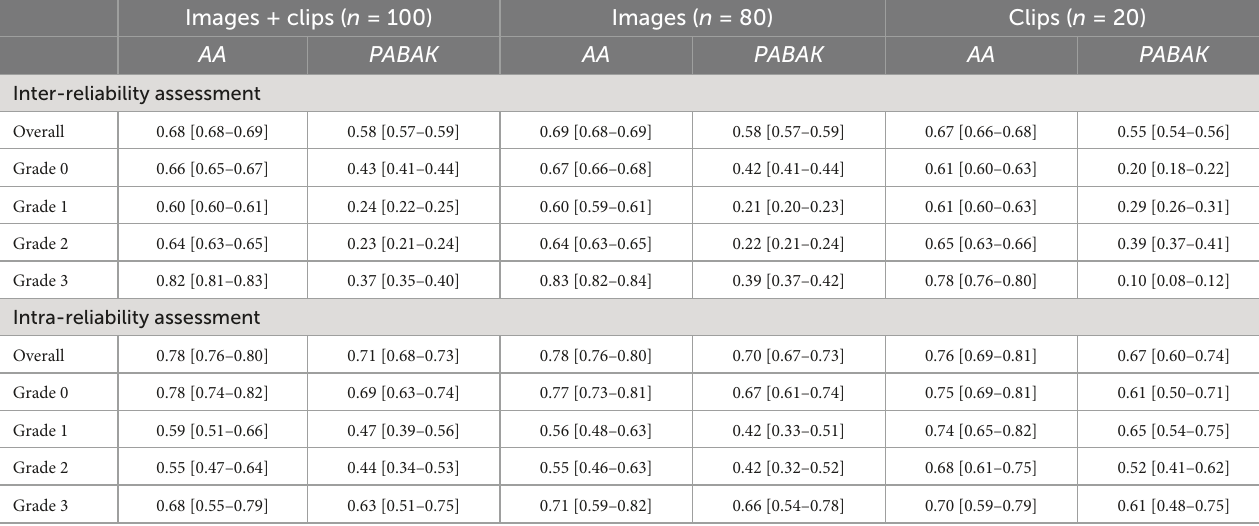
TABLE 3 Reliability assessment of the visual semi-quantitative scale for muscle echogenicity.